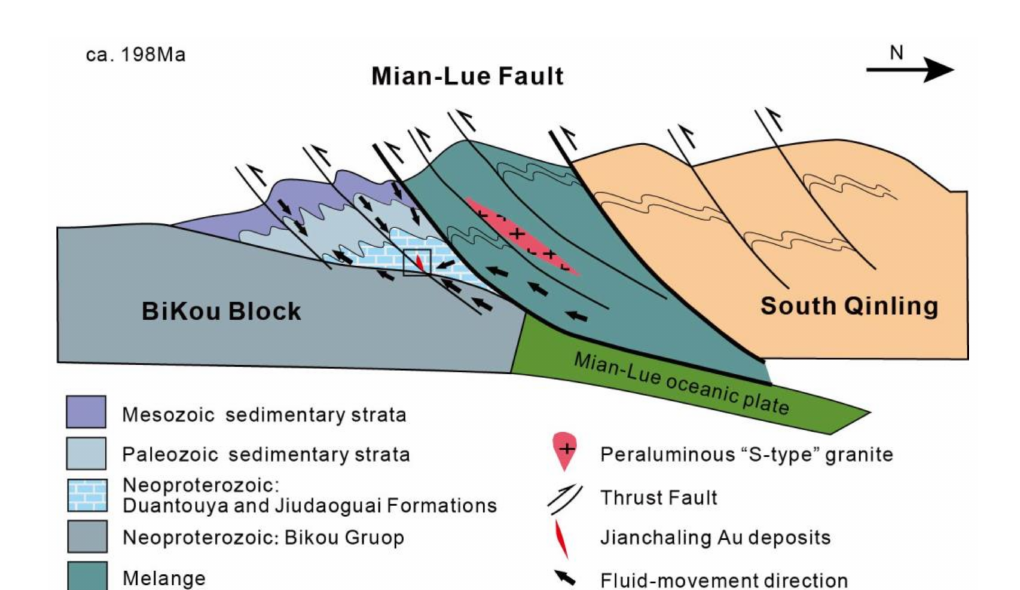
Figure 11. Tectonic model for the Jianchaling Au deposit